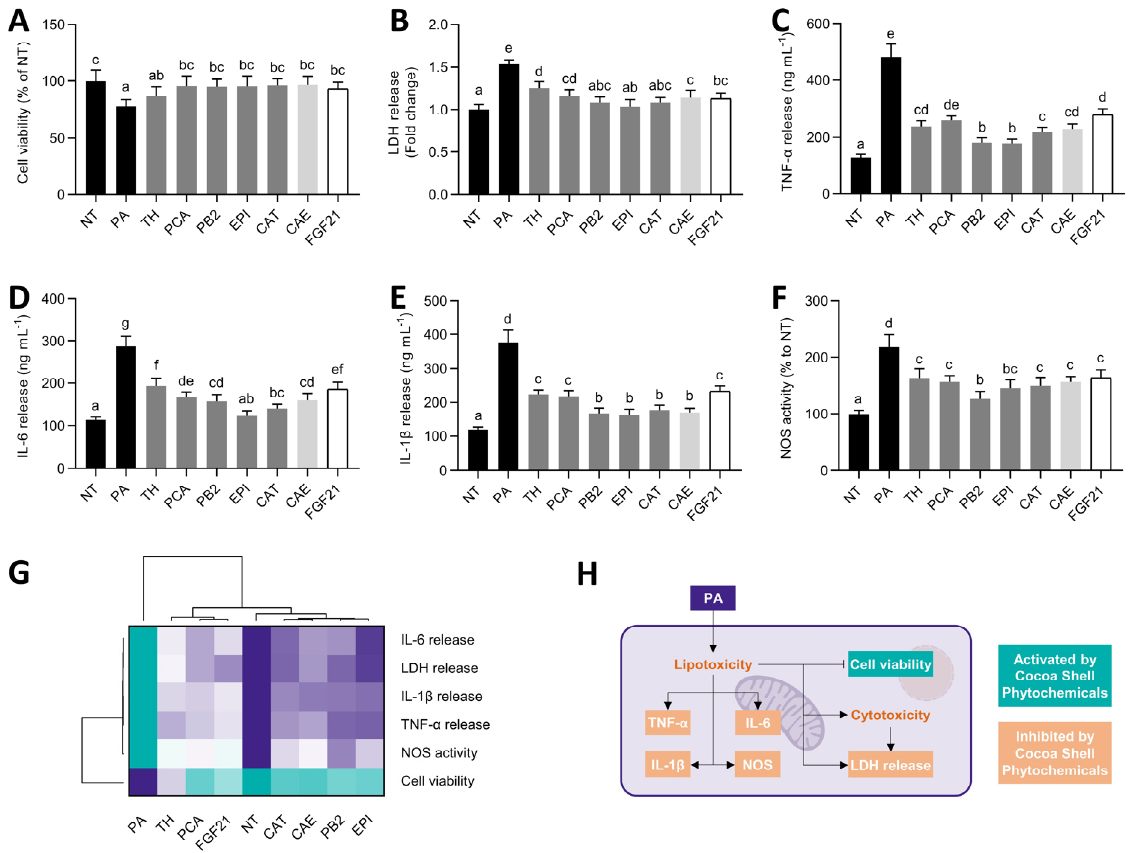
Figure 4. Protective effects of pure phytochemicals from the cocoa shell (50 µmol L − 1 ), aqueous ex- tract (CAE, 100 µg mL − 1 ), and FGF21 (20 nmol L − 1 ), in the presence of palmitic acid (PA, 500 µmol L − 1 ) against oxidative stress in HepG2 human hepatocytes. Phytochemicals from the cocoa shell re- Figure 3. Role of pure phytochemicals from the cocoa shell (50 µmol L − 1 ), aqueous extract (CAE, 100 Figure 3. Role of pure phytochemicals from the cocoa shell (50 µ mol L − 1 ), aqueous extract (CAE, duced the production of reactive oxygen species (ROS) ( A ) and mitochondrial O 2• − ( B ) while main- Figure 3. Role of pure phytochemicals from the cocoa shell (50 µmol L − 1 ), aqueous extract (CAE, 100 µg mL − 1 ), and FGF21 (20 nmol L − 1 ), in the presence of palmitic acid (PA, 500 µmol L − 1 ), on lipo/cyto- 100 µ g mL − 1 ), and FGF21 (20 nmol L − 1 ), in the presence of palmitic acid (PA, 500 µ mol L − 1 ), on taining the mitochondrial membrane potential ( Δ Ψ m) ( C ) in PA-treated hepatocytes. The enzymatic µg mL − 1 ), and FGF21 (20 nmol L − 1 ), in the presence of palmitic acid (PA, 500 µmol L − 1 ), on lipo/cyto- toxicity and inflammation markers in HepG2 human hepatocytes. Cocoa shell phytochemicals pre- lipo/cytotoxicity and inflammation markers in HepG2 human hepatocytes. Cocoa shell phyto- activity of NADPH oxidase (NOX) ( D ), superoxide dismutase (SOD) ( E ), and catalase ( F ) were reg- toxicity and inflammation markers in HepG2 human hepatocytes. Cocoa shell phytochemicals pre- served cell viability ( A ) and diminished lactate dehydrogenase (LDH) release ( B ). PA-triggered chemicals preserved cell viability ( A ) and diminished lactate dehydrogenase (LDH) release ( B ). ulated, thereby diminishing oxidative stress via the activation of the Nrf2 pathway by stimulating served cell viability ( A ) and diminished lactate dehydrogenase (LDH) release ( B ). PA-triggered TNF- α ( C ), IL-6 ( D ), and IL-1 β ( E ) release and nitric oxide synthase (NOS) activity ( F ) were reduced. PA-triggered TNF- α ( C ), IL-6 ( D ), and IL-1 β ( E ) release and nitric oxide synthase (NOS) activity ( F ) its protein expression and phosphorylation ( G ). Hierarchical cluster analysis and heat map (from TNF- α ( C ), IL-6 ( D ), and IL-1 β ( E ) release and nitric oxide synthase (NOS) activity ( F ) were reduced. Hierarchical cluster analysis and heat map (from the lowest ( ) to the highest ( ) value for each the lowest ( ) to the highest ( ) value for each parameter) ( H ) and an integrative diagram illustrat- were reduced. Hierarchical cluster analysis and heat map (from the lowest ( ) value Hierarchical cluster analysis and heat map (from the lowest ( ) to the highest ( ) value for each parameter) ( G ) and an integrative diagram illustrating the effects of the phytochemicals from the ing the effects of the phytochemicals from the cocoa shell on oxidative stress ( I ). The results are parameter) ( G ) and an integrative diagram illustrating the effects of the phytochemicals from the for each parameter) ( G ) and an integrative diagram illustrating the effects of the phytochemicals from cocoa shell on lipo/cytotoxicity and inflammation ( H ). The results are expressed as mean ± SD ( n = expressed as mean ± SD ( n = 3). Bars with different letters (a–f) significantly ( p < 0.05) differ accord- cocoa shell on lipo/cytotoxicity and inflammation ( H ). The results are expressed as mean ± SD ( n = 3). Bars with different letters (a–f) significantly ( p < 0.05) differ according to ANOVA and Tukey’s the cocoa shell on lipo/cytotoxicity and inflammation ( H ). The results are expressed as mean ± SD ing to ANOVA and Tukey’s test. NT: non-treated cells; TH: theobromine; PCA: protocatechuic acid; 3). Bars with different letters (a–f) significantly ( p < 0.05) differ according to ANOVA and Tukey’s multiple range test. NT: non-treated cells; TH: theobromine; PCA: protocatechuic acid; PB2: procy- ( n = 3). Bars with different letters (a–f) significantly ( p < 0.05) differ according to ANOVA and PB2: procyanidin B2; EPI: epicatechin; CAT: catechin; FGF21: fibroblast growth factor 21. multiple range test. NT: non-treated cells; TH: theobromine; PCA: protocatechuic acid; PB2: procy- anidin B2; EPI: epicatechin; CAT: catechin; FGF21: fibroblast growth factor 21. Tukey’s multiple range test. NT: non-treated cells; TH: theobromine; PCA: protocatechuic acid; anidin B2; EPI: epicatechin; CAT: catechin; FGF21: fibroblast growth factor 21.